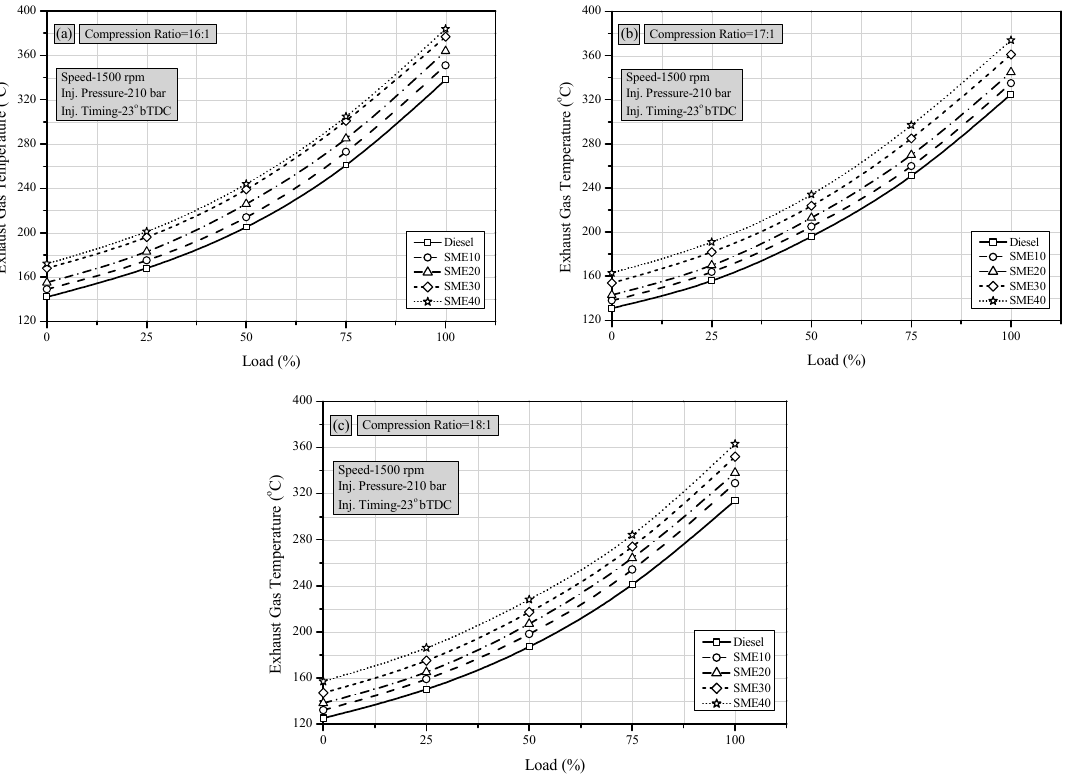
Figure 6. Variation of EGT with load for the fuel blends at CRs: ( a ) 16:1 ( b ) 17:1 ( c ) 18:1.